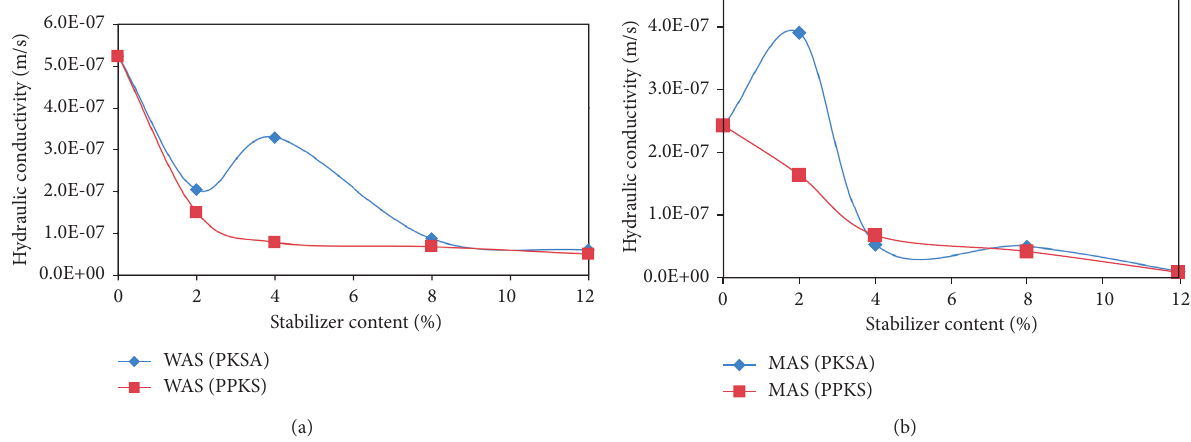
Figure 8: Hydraulic conductivity versus PKSA and PPKS for the treated shale at MAS and WAS methods.